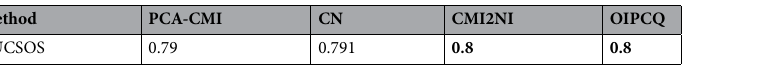
Table 12. Comparison of AUC for real data sets (AUCSOS: AUC values for a SOS network with 9 genes). Best results are indicated in